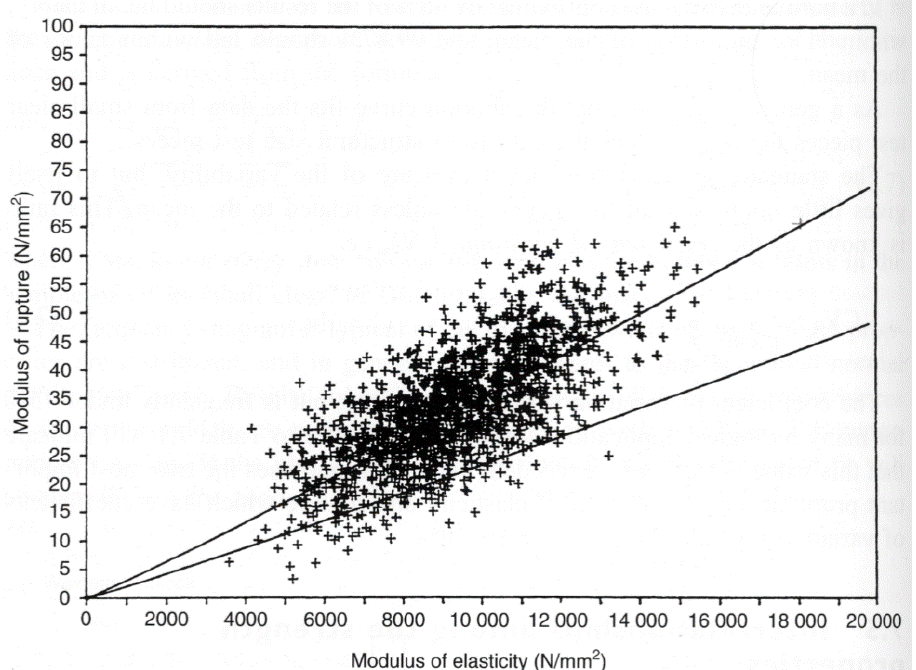
Figure 20. Data obtained from 1348 tests for the modulus of rupture (MOR) and the modulus of elasticity (MOE). The mean regression line and the 5th percentile exclusion line are plotted. The (over-precise) equation that Dinwoodie gave for the mean regression line was MOR = 0.002065(MOE) 1.0573 with a correlation coefficient of 0.702. From [89]. ‘+’ signs are data points.